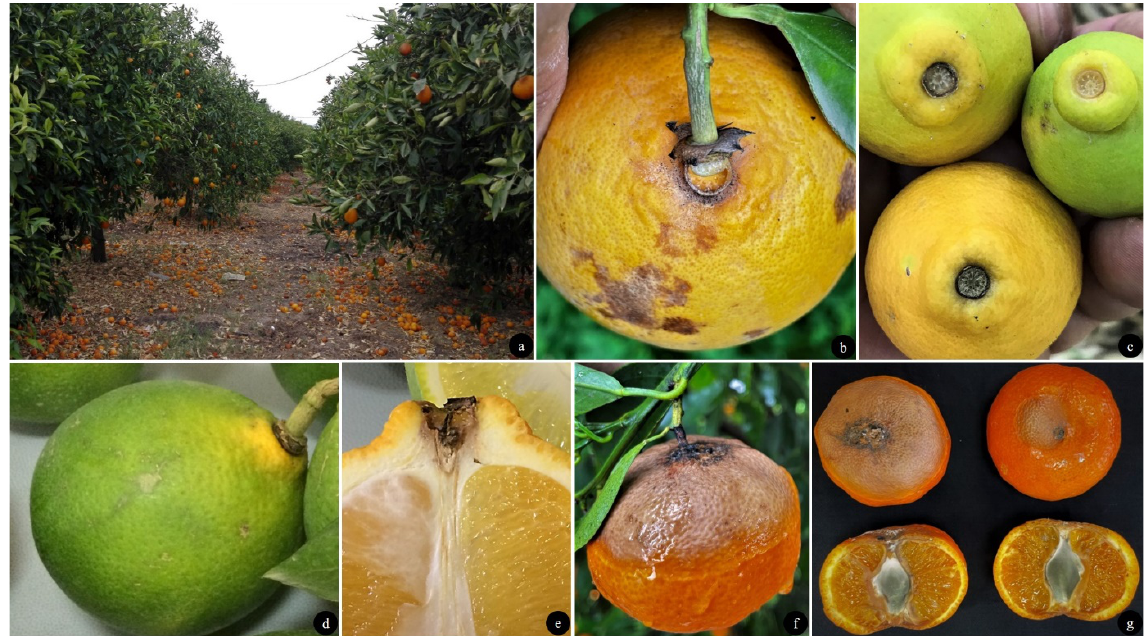
Figure 5. Pre-harvest fruit drop: ( a ) severe fruit drop on “Tarocco Scirè VCR” orchard; ( b ) calix blight and brown to blackish discoloration of the rind at the stem-end of immature “Tarocco Sciara” fruit; ( c , d ) fruit drop of immature fruit of “Tarocco Sciara” with premature coloring; ( e ) detail of a longitudinal section of fruit showing stem-end rot; ( f ) extensive black rot on “Mandalate” mandarin; ( g ) black rot symptom on central column of “Mandalate” mandarin.